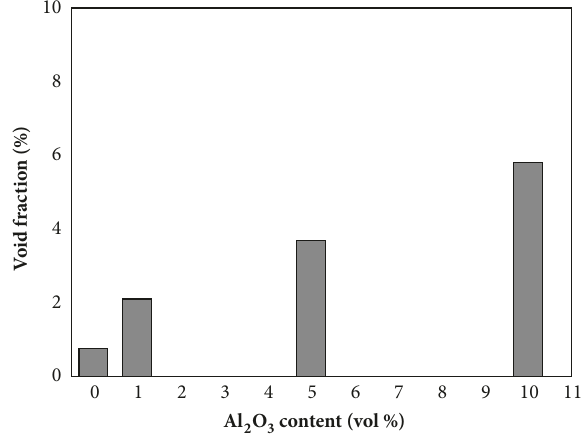
Figure 5: Plot of void contents inside the prepared polyester/alumina composites.